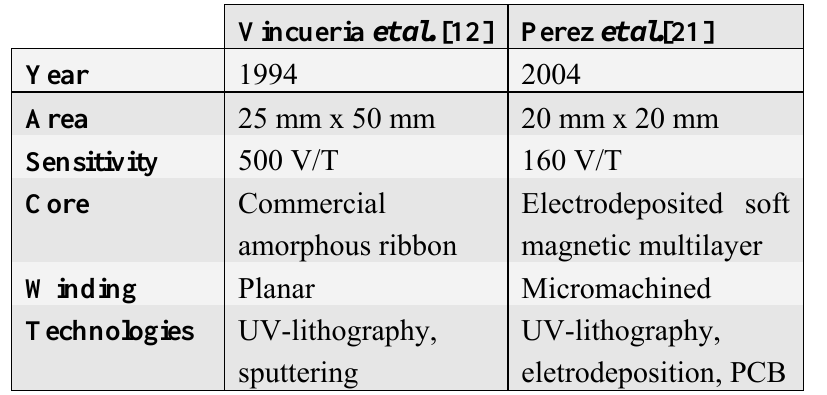
Table 1. Comparison between two different fluxgates by